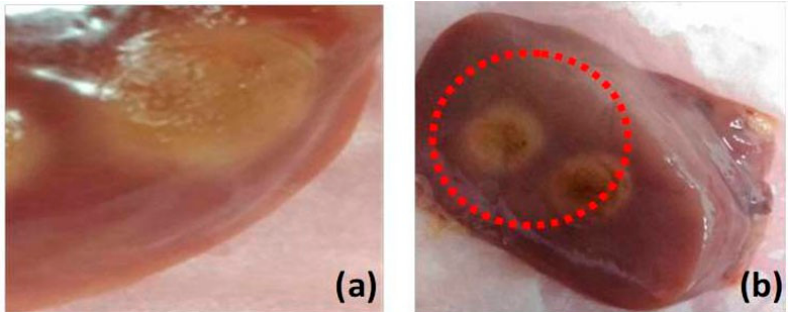
Figure 1. Photograph of chicken tissue ( a ) muscle and ( b ) liver. Discolored part indicates the coagulated regions.